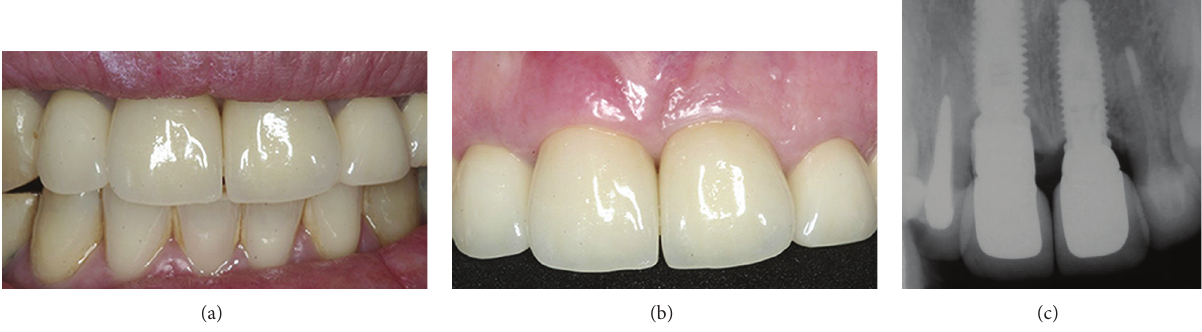
Figure 11: (a, b) Three years follow-up; the result showed esthetic excellence of the definitive prosthesis; (c) periapical radiograph. Three-year follow-up showing the accurate fit between the abutments and implants and between the crowns and